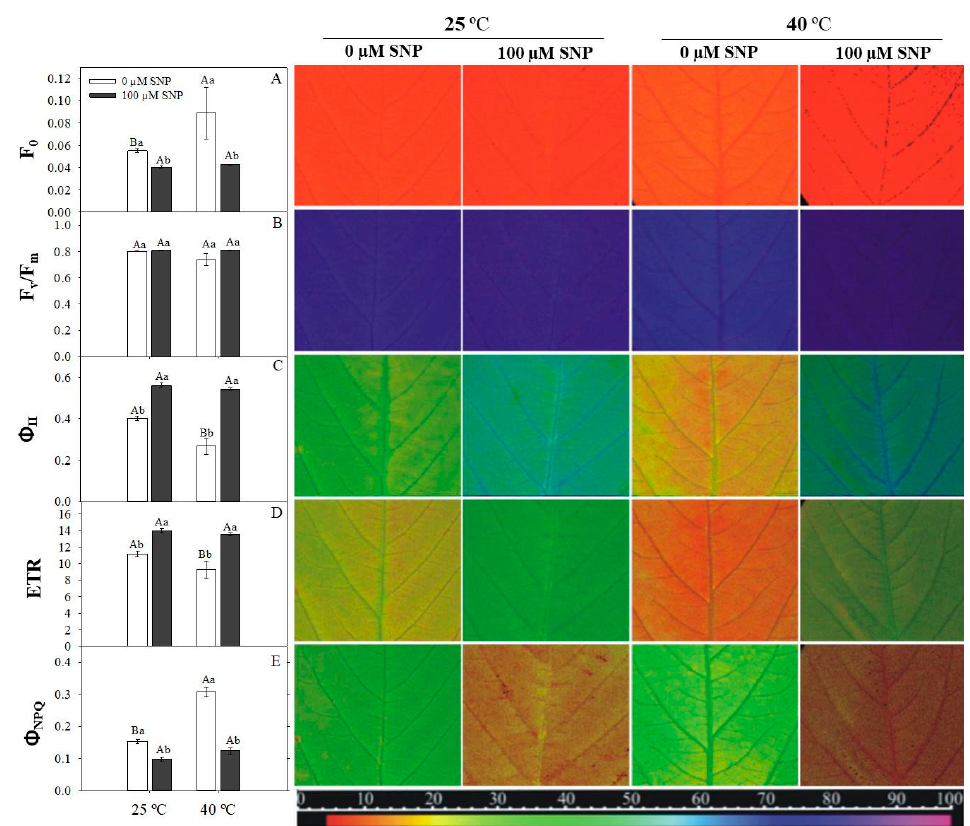
Figure 5. Minimal chlorophyll fluorescence (F 0 , A ), maximum photosystem II (PSII) quantum yield ( F v / F m , B ), effective PSII quantum yield (Y II , C ), apparent electron transport rate (ETR, D ), and quantum yield of regulated energy dissipation (Y NPQ , E ) in soybean plants submitted to two doses of SNP (0 and 100 μ M) and two temperatures (25 °C and 40 °C). Bars represent means of five replicates ± SE. Means followed by the same upper- and lowercase letters within the temperatures do not differ by the Tukey test ( p < 0.05). The false color code depicted at the bottom of images ranges from 0 (black) to 100 (pink). For interpretation of the references to color in this figure legend, the reader is referred to the web version of this article.